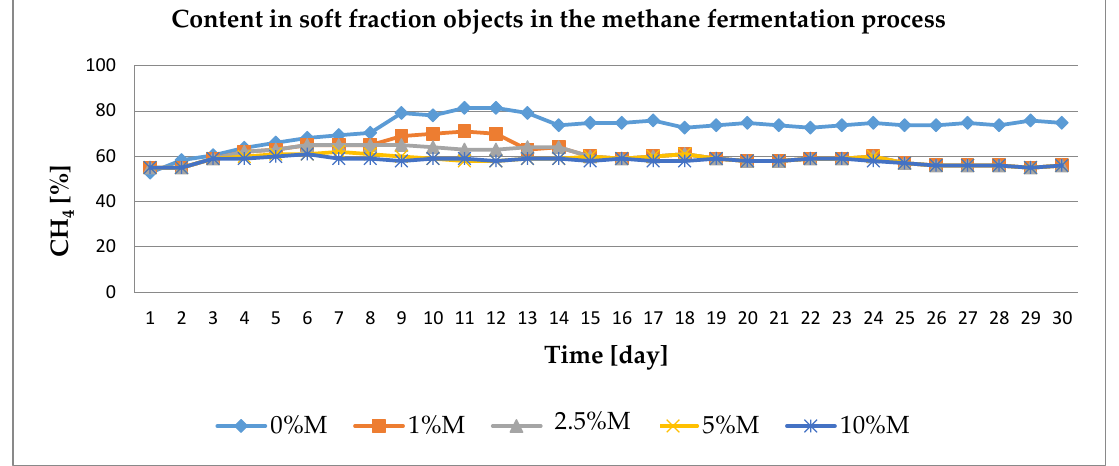
Figure 3. Methane content in soft fraction objects in the methane fermentation process.